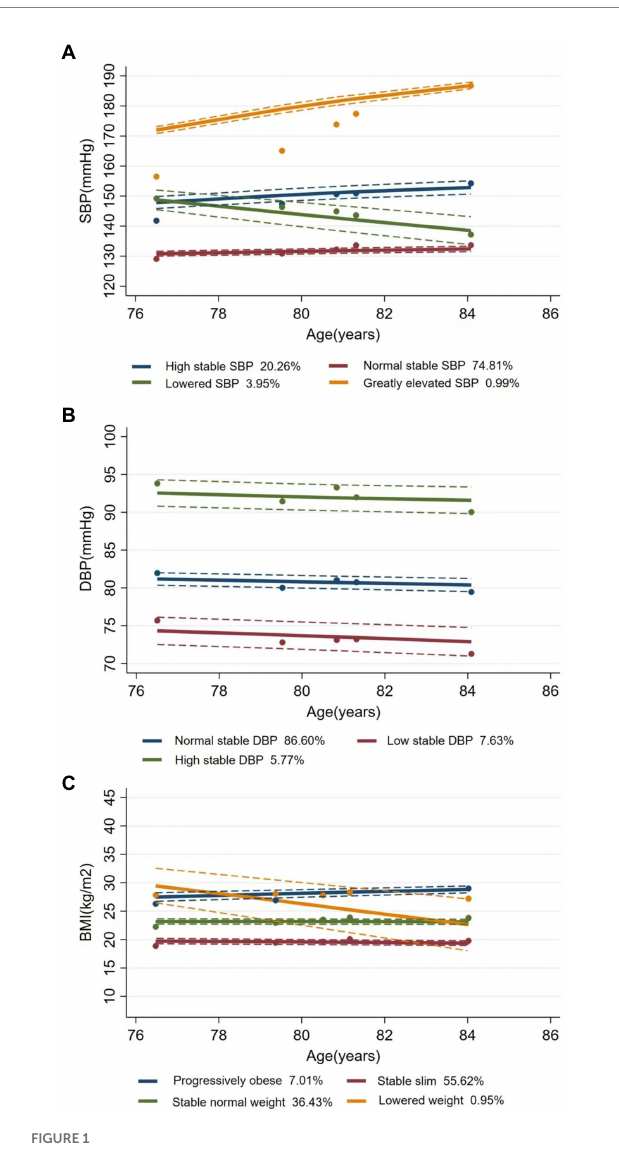
FIGURE 1 Latent trajectories of SBP (A) , DBP (B) , and BMI (C) for Chinese older people. Estimated trajectories (solid lines), observed group means for each survey (dot symbols). Dashed lines are approximated 95% pointwise CIs on the estimated trajectories. SBP, systolic blood pressure; DBP, diastolic blood pressure; BMI, body mass